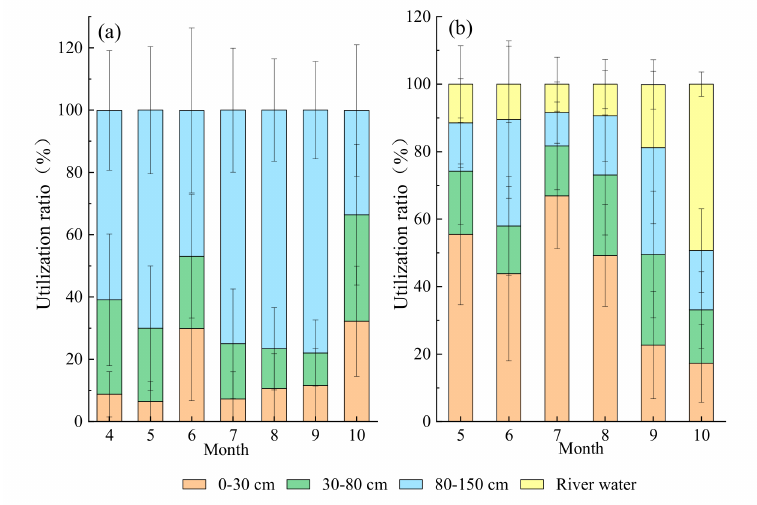
Figure 7. Monthly variations in contribution ratios of potential water sources to T. ramosissima based on MixSIAR in hillside ( a ) and floodplain ( b ) habitats (Mean ± SD, N =